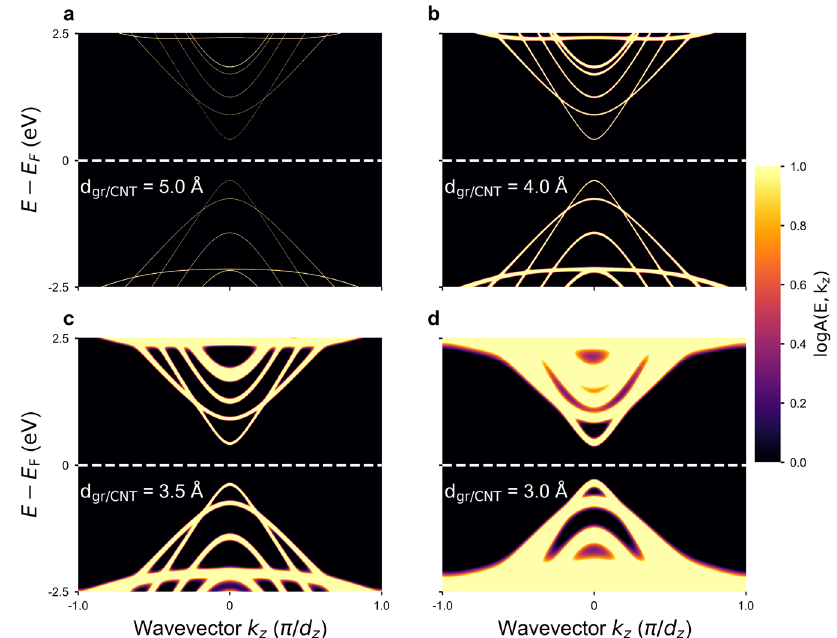
Fig. 2 The spectral function of the carbon nanotube at varying carbon nanotube/graphene spacing. The interaction strength between the graphene electrode and the carbon nanotube (CNT) on top is related to the broadening of the peaks in the spectral function A ( E , k z ): strong interactions cause smearing of A ( E , k z ). The spectral function is plotted in a 2D-heatmap plot over the Energy E (with respect to the Fermi level E F ) and the wavevector k z . a At a spacing of d gr/CNT = 5.0 Å , the peaks are sharp and distinct. Smaller spacings lead to a smearing of the peaks, although the key features (bands and bandgap) are still visible ( b and c ). d At a spacing of 3.0 Å , some bands overlap while the semiconducting property of the CNT remains. This indicates that graphene electrodes do not destroy the semiconducting property of the CNT by metalizing it, as reported for Ni or Ti contacts 27 . The scale bar shows the logarithmic spectral function log A ð E ; k z Þ normalized to the range of values between 0 and 1.